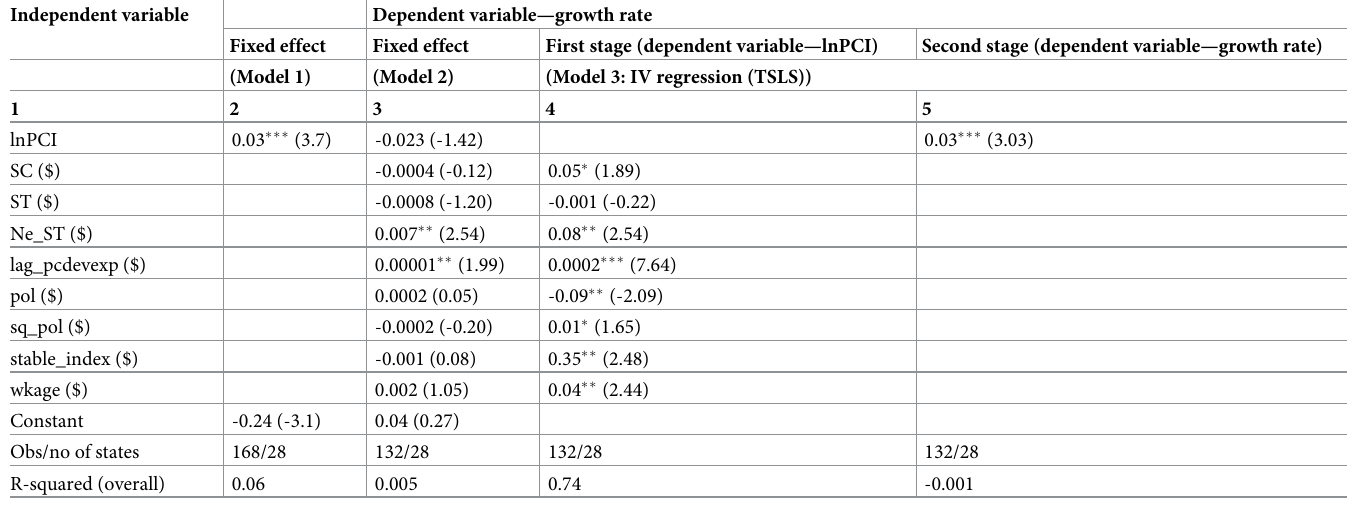
Table 2. Growth model estimates of panel and instrumental variable approach